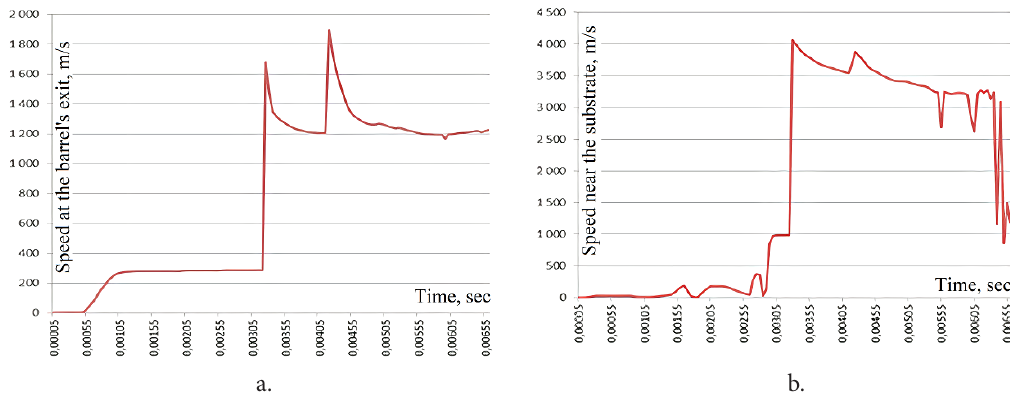
Figure 1. Carrier gas speed paramenters: a – at the barrel’s exit of the D-gun; b – near the substrate